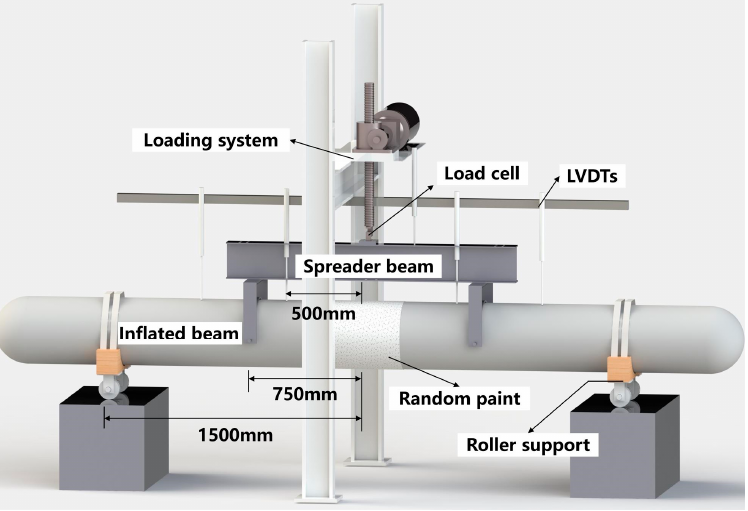
Figure 3. Four-points bend test setup diagram.